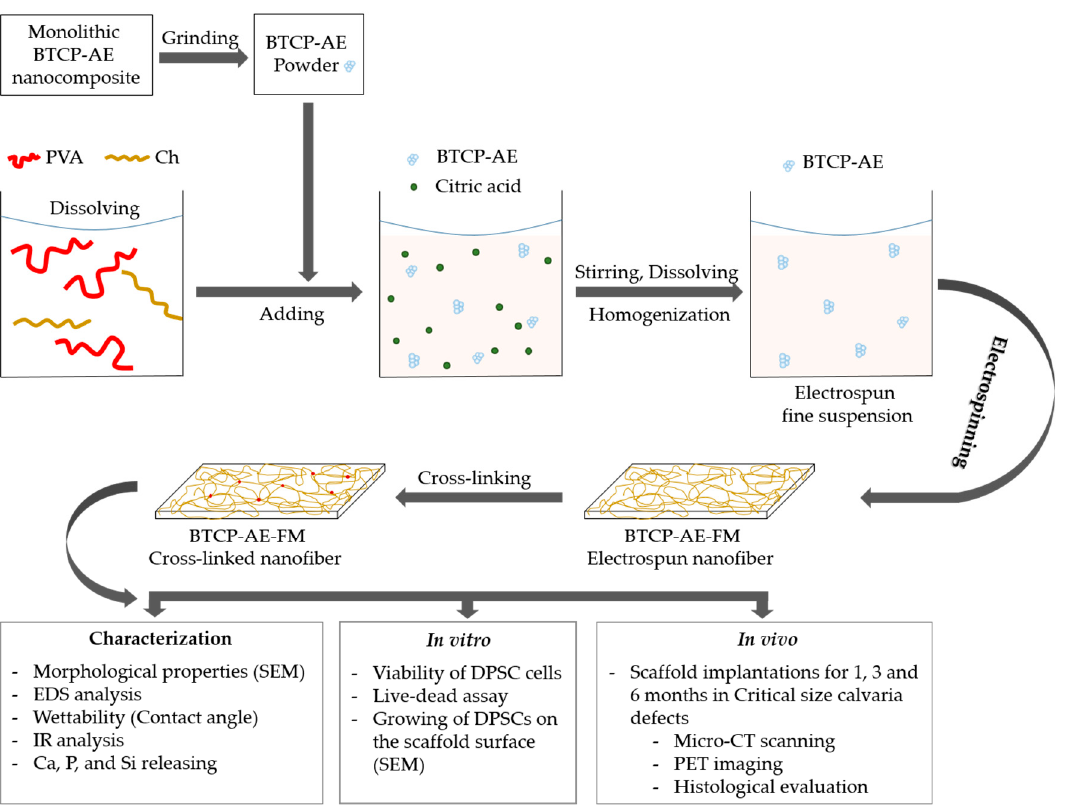
Figure 15. Work fl ow of the fabrication, characterization, and in vitro and in vivo investigations of chemically cross-linked biodegradable